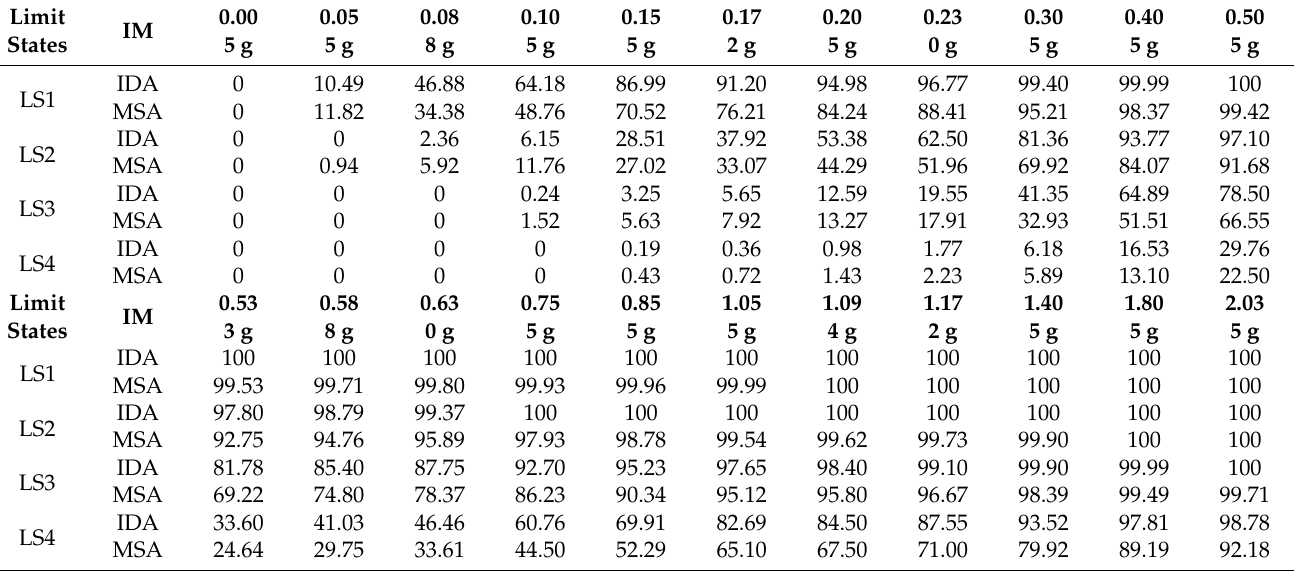
Figure 13. Comparison of IDA and MSA. Table 9. Probability under various earthquake intensities